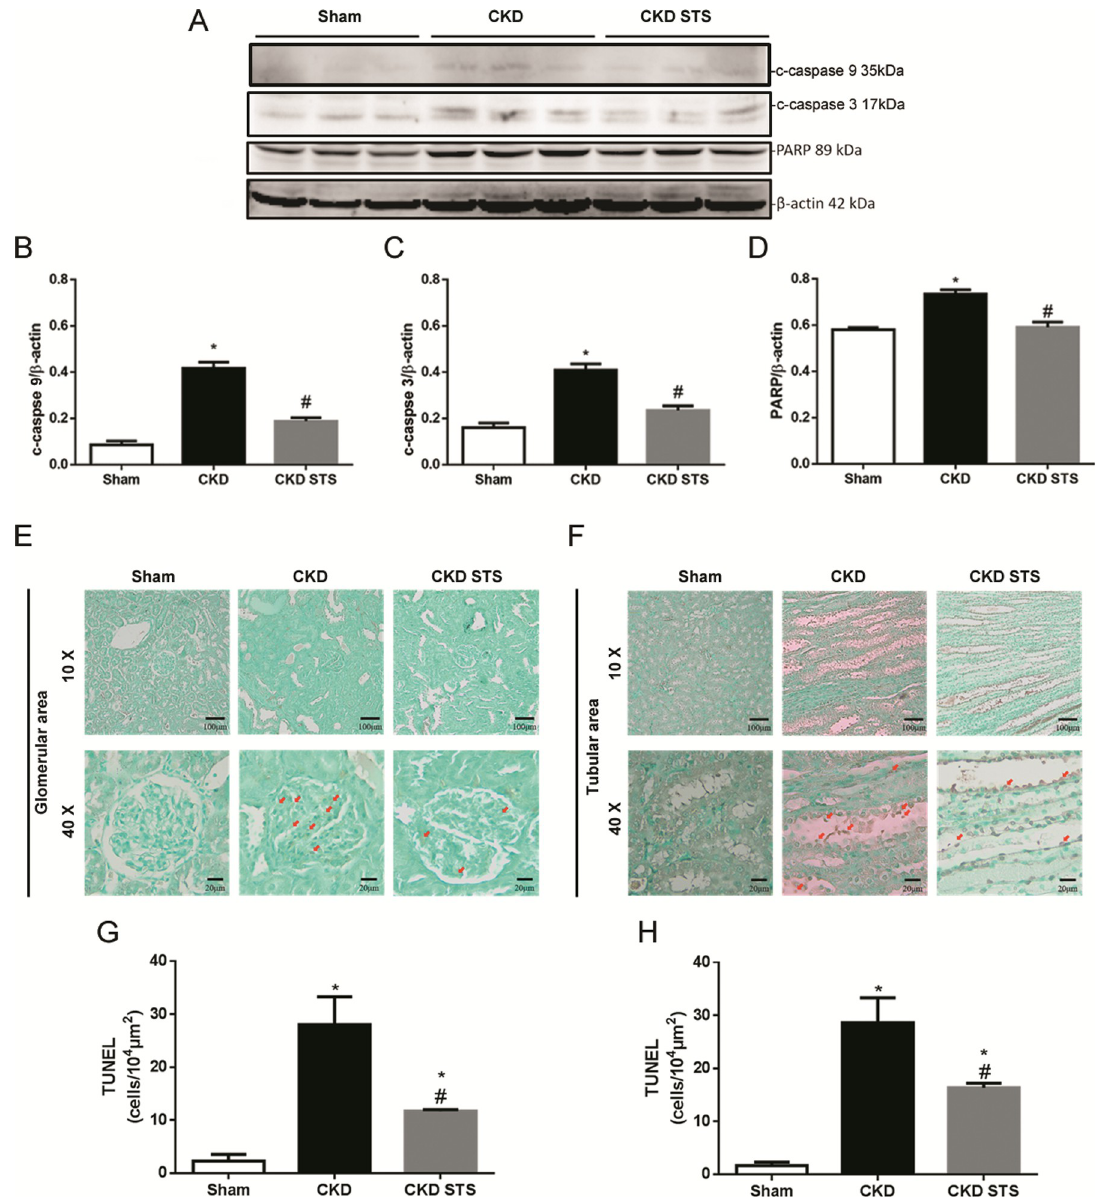
counting in CKD induced kidney injury. Data are expressed as mean ± SEM (n = 3). � P < 0.05 vs. Sham. # P < 0.05 vs.